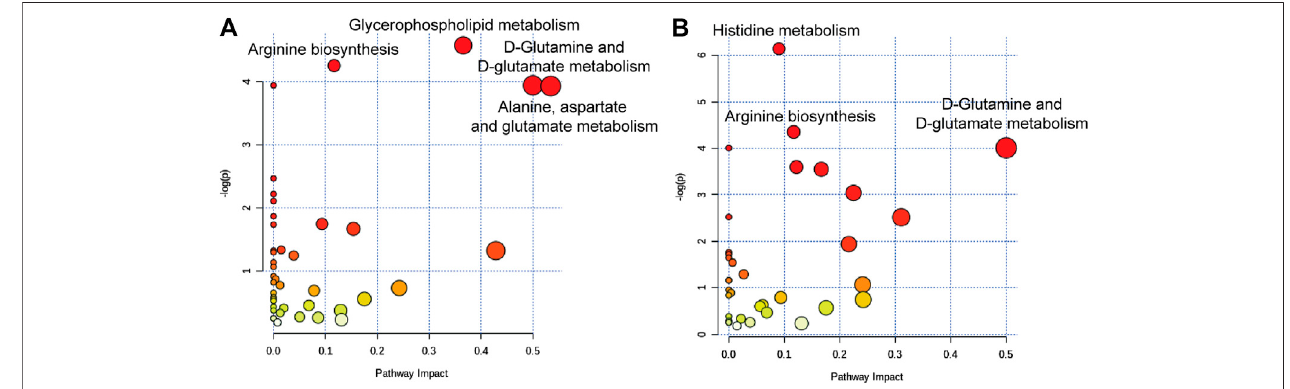
FIGURE 6 | MDA contents in the serum of vehicle-, raw SO- and PSO- treated rats. * p < 0.05 vs. control.